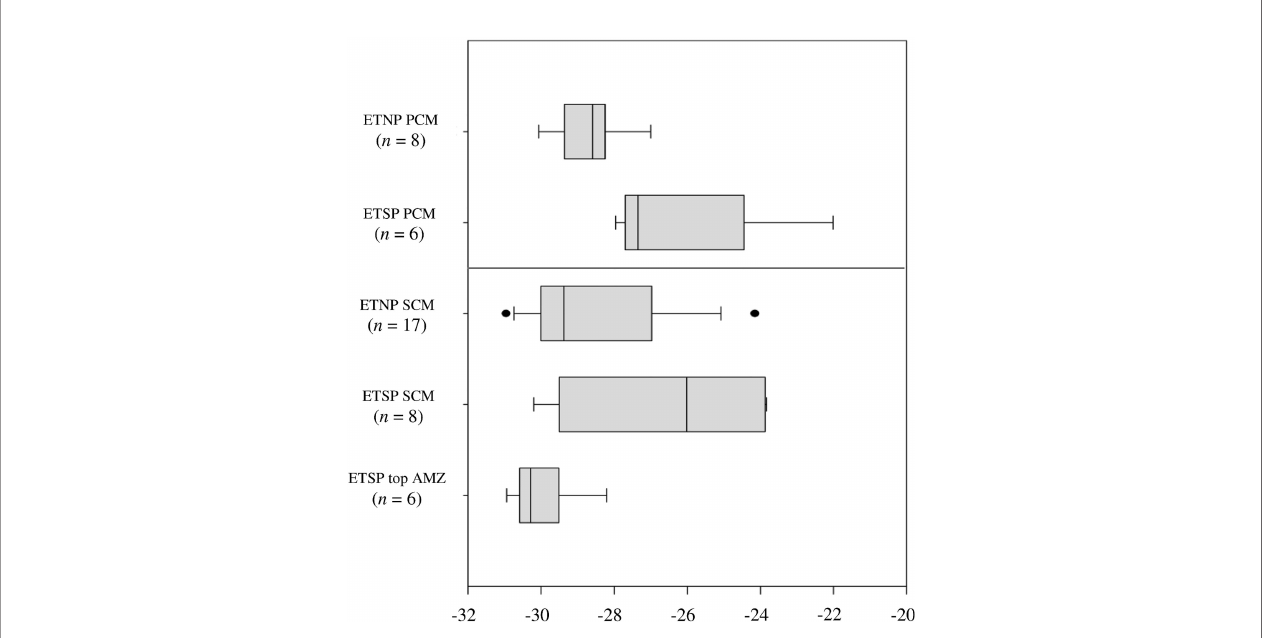
FIGURE 3 | Boxplot of natural abundance of d 13 C ( ‰ ) of POC (0.3 – 3.0 m m size fraction) during the ETNP and ETSP cruises. PCM indicates primary chlorophyll maximum (top panel), SCM indicates secondary chlorophyll maximum and “ ETSP top AMZ ” indicates samples taken at the top of the AMZ when no SCM was present (bottom panel). n is the number of measurements per group. The bars indicate the minimum and the maximum values, and the dots indicate the outliers.